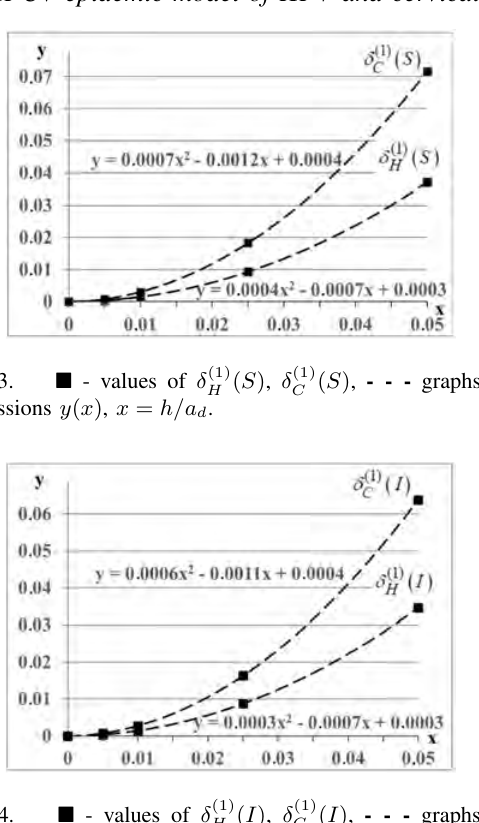
Fig. 4. (cid:4) - values of δ (1) regressions y ( x ) , x = h/a d .